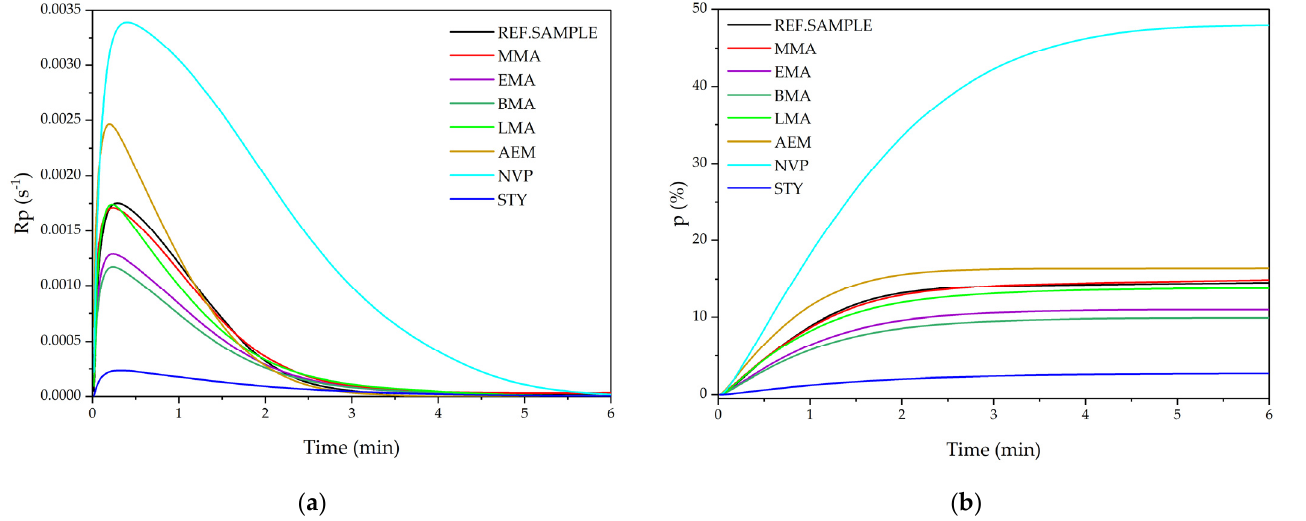
Figure 3. The photopolymerization rates ( a ) and monomers conversions ( b ) of the base composition (reference sample) and the compositions with the additional comonomer.